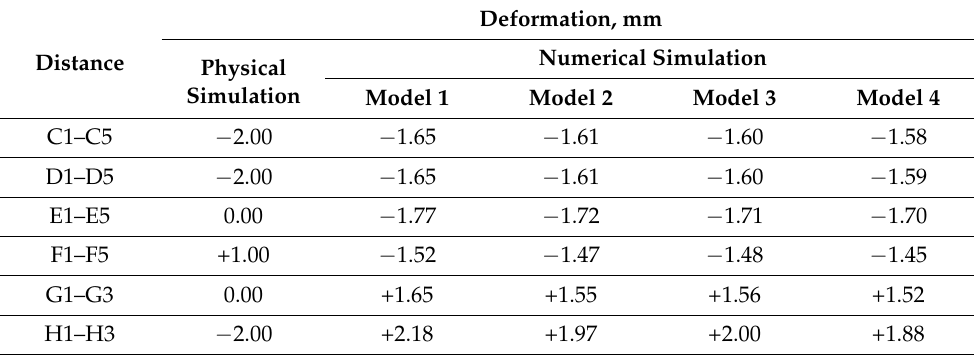
Table 5. Deformation of the linear dimensions specified in the physical and numerical simulation of the welding process of the industrial furnace wall panel.